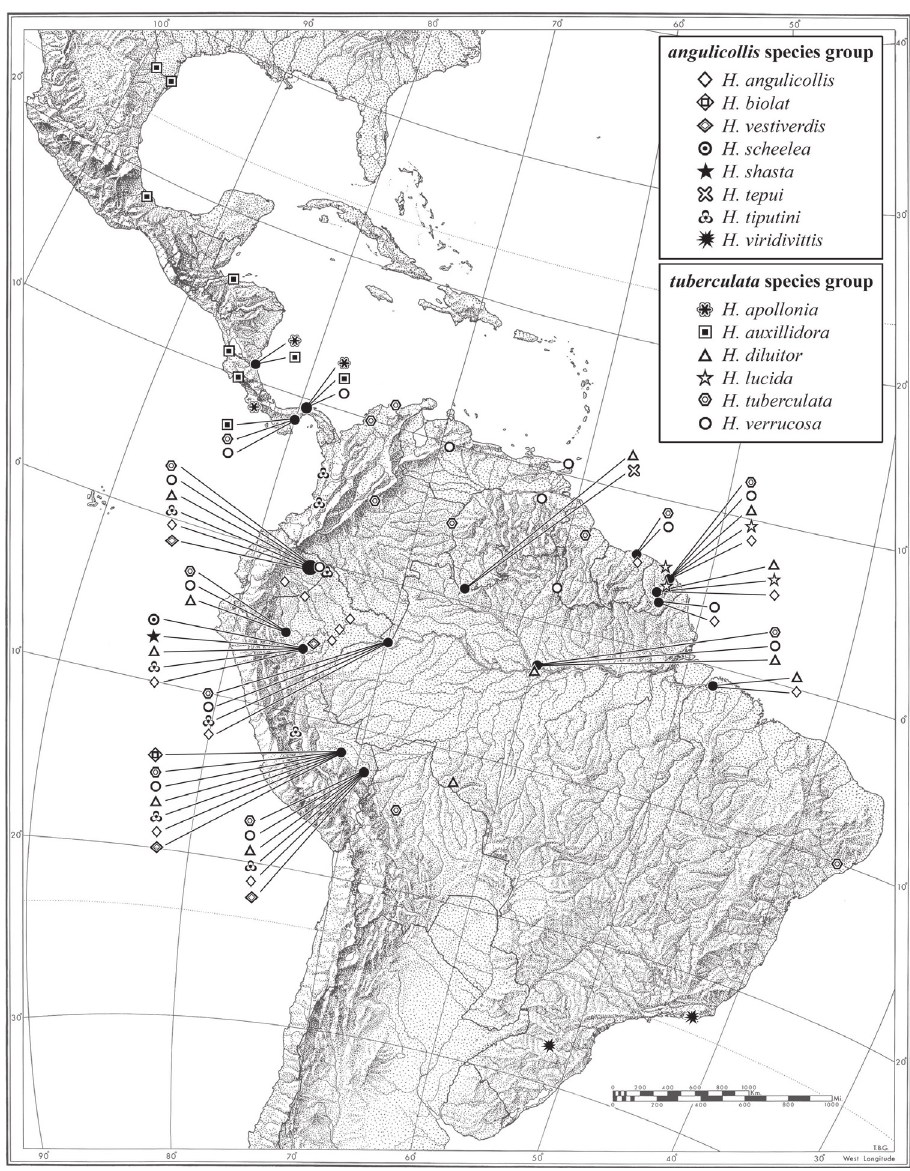
Figure 11. Distribution map for known localities of Hyboptera Male genitalia : Phallus (Fig. 10D) robust with ostium of 1/6 its length, catopic, apex very short, broadly rounded in dorsal and lateral aspects; endophallus with flagel- lum (obvious in illustration), flagellum not barbed. Parameres asymmetric, right very small, left larger. Female genitalia : Not investigated, likely similar to that of H. lucida (Fig. 8).